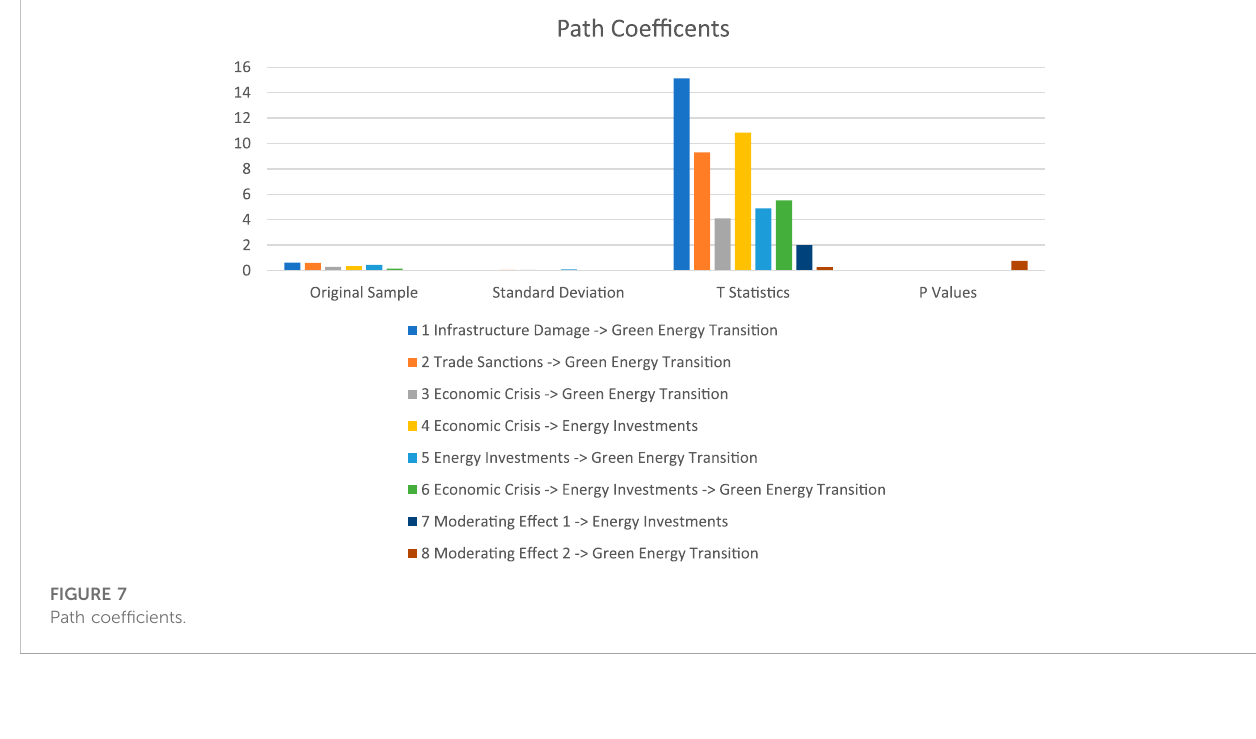
TABLE 7 Predictive relevance.